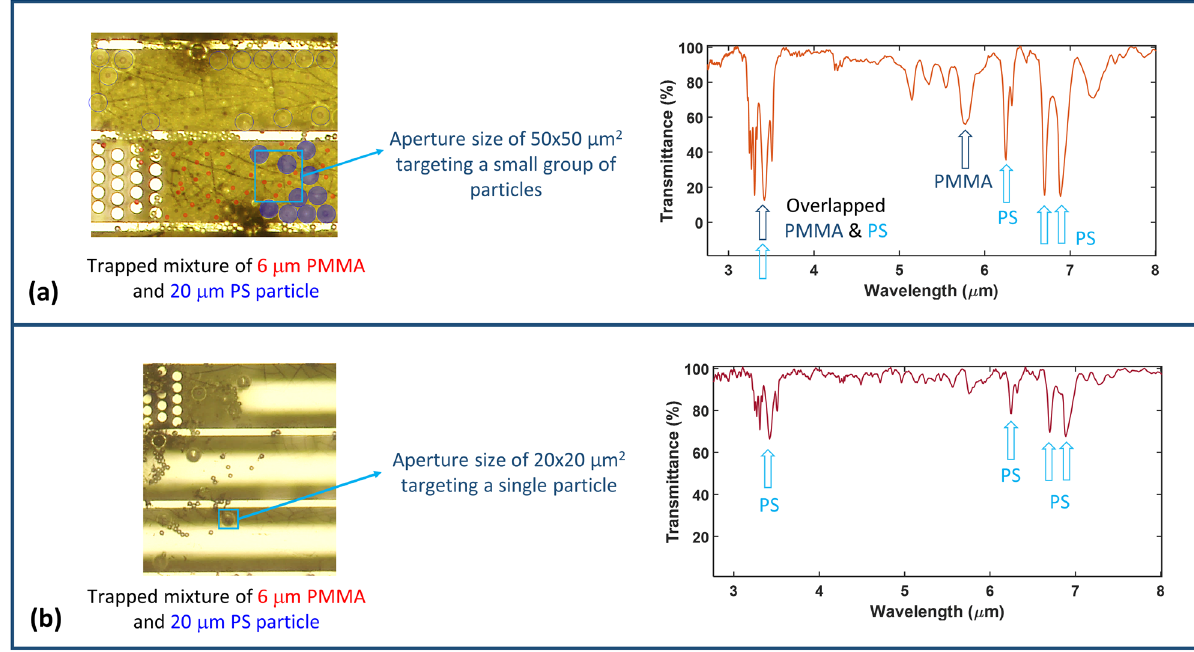
Figure 6. FTIR microscope measurements. ( a ) A microscope image of the chip reservoir containing the trapped particles of 6 µm PMMA and 20 µm PS, given that the aperture size is 50 × 50 µm 2 and is highlighted in dashed blue. Shown next to it is the obtained IR spectrum for the trapped particles showing the absorption dips of both PMMA and PS. ( b ) A microscope image showing the analyzed single particle given that the aperture size is 20 × 20 µm 2 and is highlighted in red, and shown next to it the obtained IR spectrum for the targeted particle showing the absorption dips of PS.